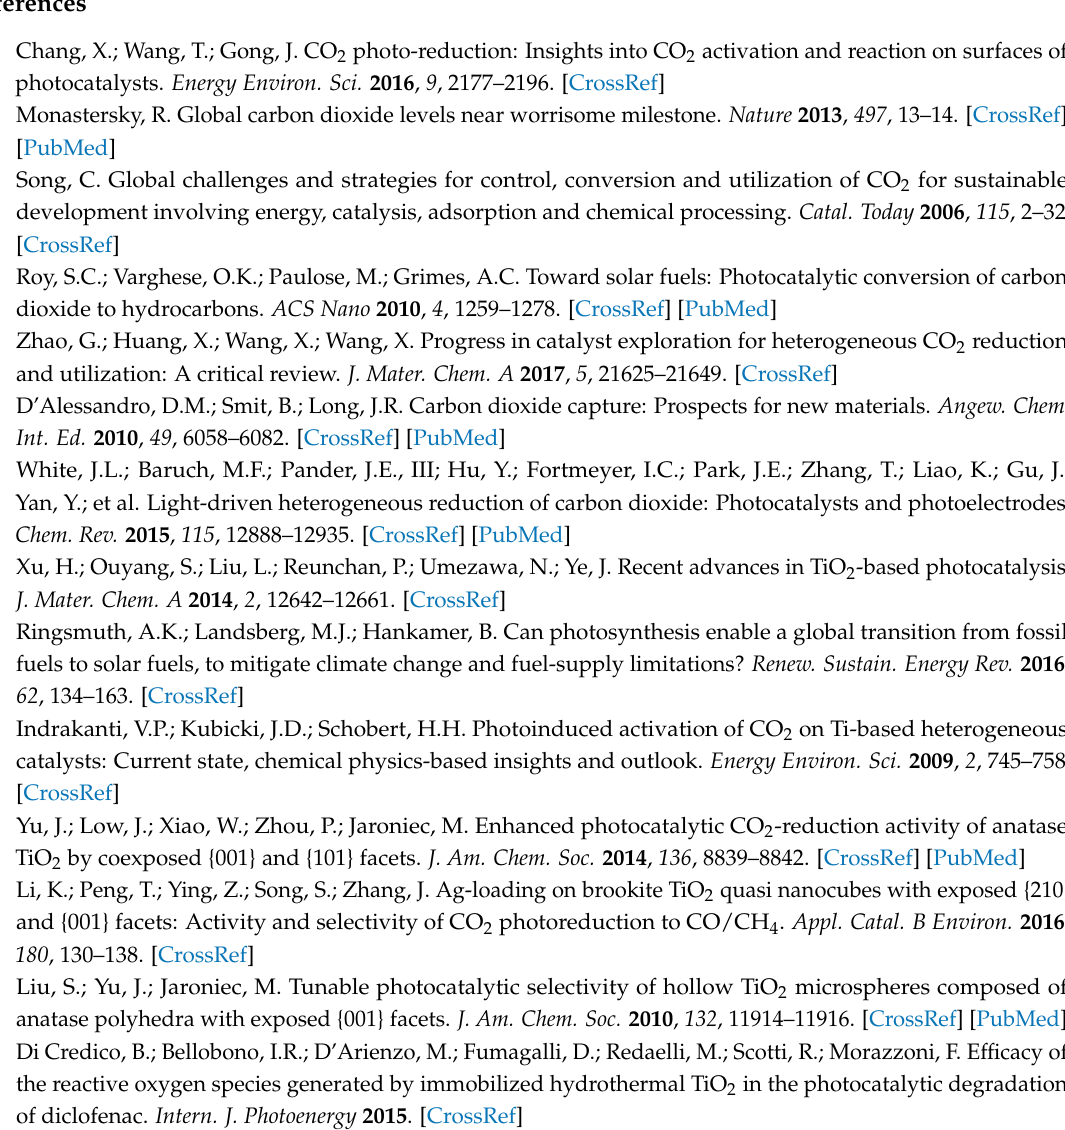
Table S1: Structural parameters and porosity of RE TiO 2 NPs, Figure S1: TEM micrographs and related SAED analysis of TiO 2 anatase crystals and TiO 2 /HKUST-1 hybrid system, Figure S2. STEM-EDS spectra, Figure S3: Kubelka-Munk function of TiO 2 -PHA, pure HKUST-1 and TiO 2 /HKUST-1, Figure S4: XPS survey spectra of TiO 2 , TiO 2 -PHA, HKUST-1 and TiO 2 /HKUST-1, Figure S5: High resolution XPS spectra of O 1 s in HKUST-1, TiO 2 , TiO 2 -PHA and TiO 2 /HKUST-1, Table S2: Results of the photocatalytic runs in the presence of the TiO 2 -PHA sample, Table S3: Results of the photocatalytic runs in the presence of the bare HKUST-1 sample, Table S4: Results of the photocatalytic runs in the presence of the sample TiO 2 /HKUST-1, Figure S6: TEM image and PXRD pattern of TiO 2 /HKUST after the second photocatalytic